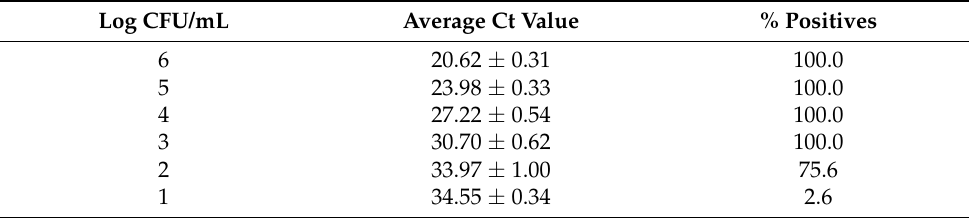
Table 1. Limit of detection for the 14 Salmonella serotypes.